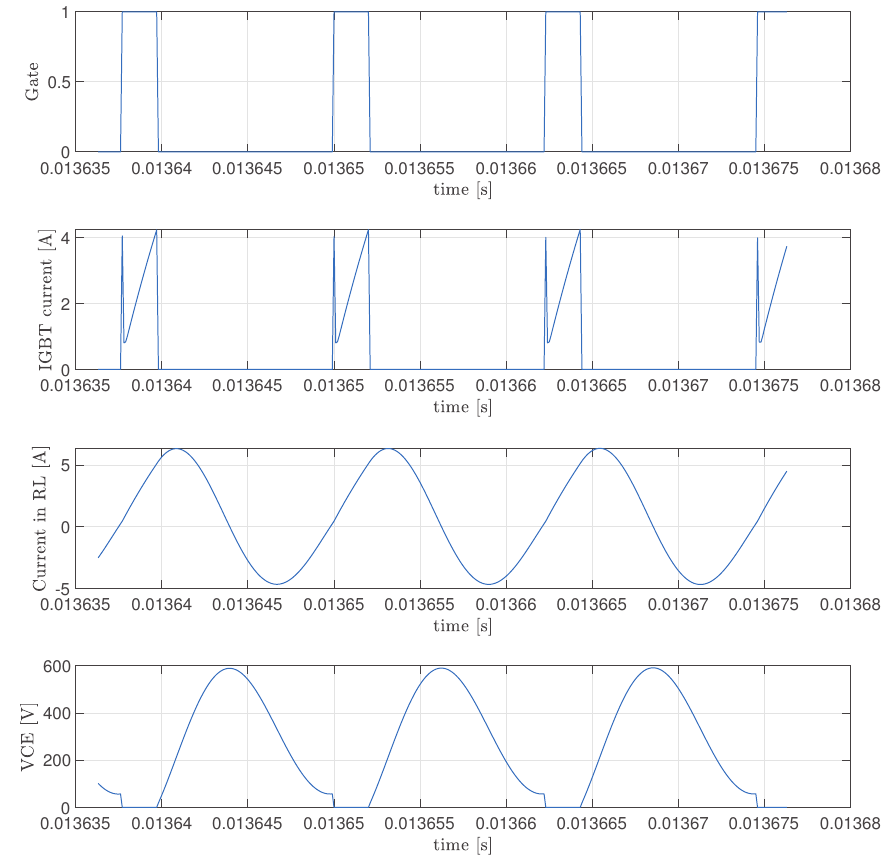
Figure 7. In order: IGBT gate control signal, flowing current in IGBT, current in the inductor and collector–emitter voltage drop on the IG resistance plots in the instant in which the maximum current flows in the inductor with nominal surface